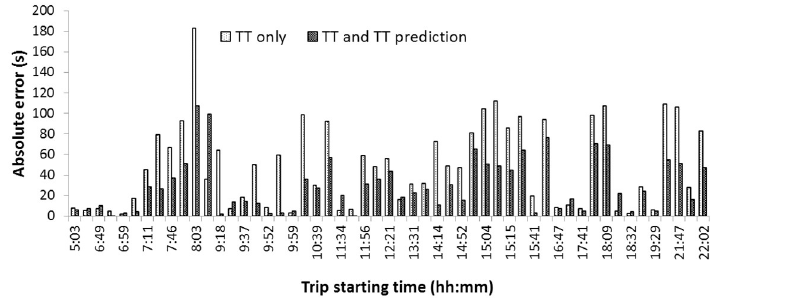
Fig 12. Effect of including prediction as a feature for clustering.